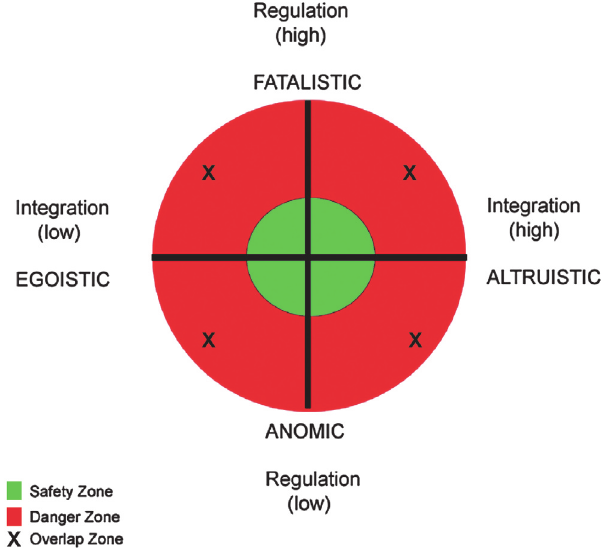
Figure 2. Durkheim’s suicide